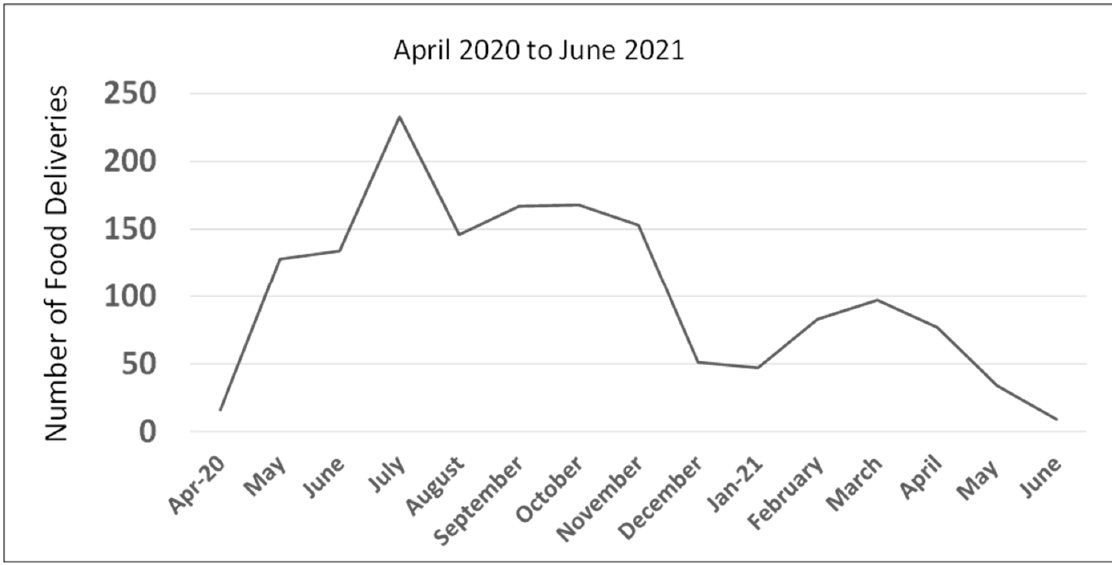
Figure 5. Number of Food Deliveries by the NeighborhoodHELP Team per Month.